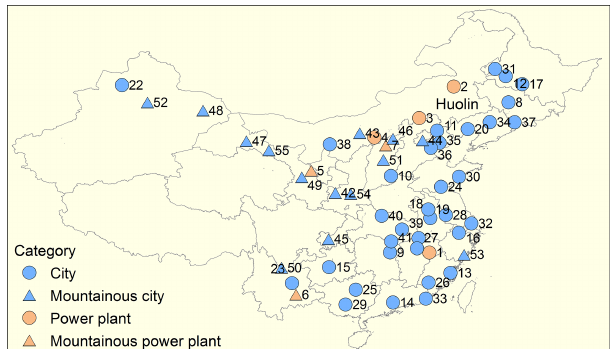
Figure 1. Locations of the selected sites in this study. The triangles represent the mountainous sites defined in Sect. 2.1. All locations are labeled with their IDs (see Table